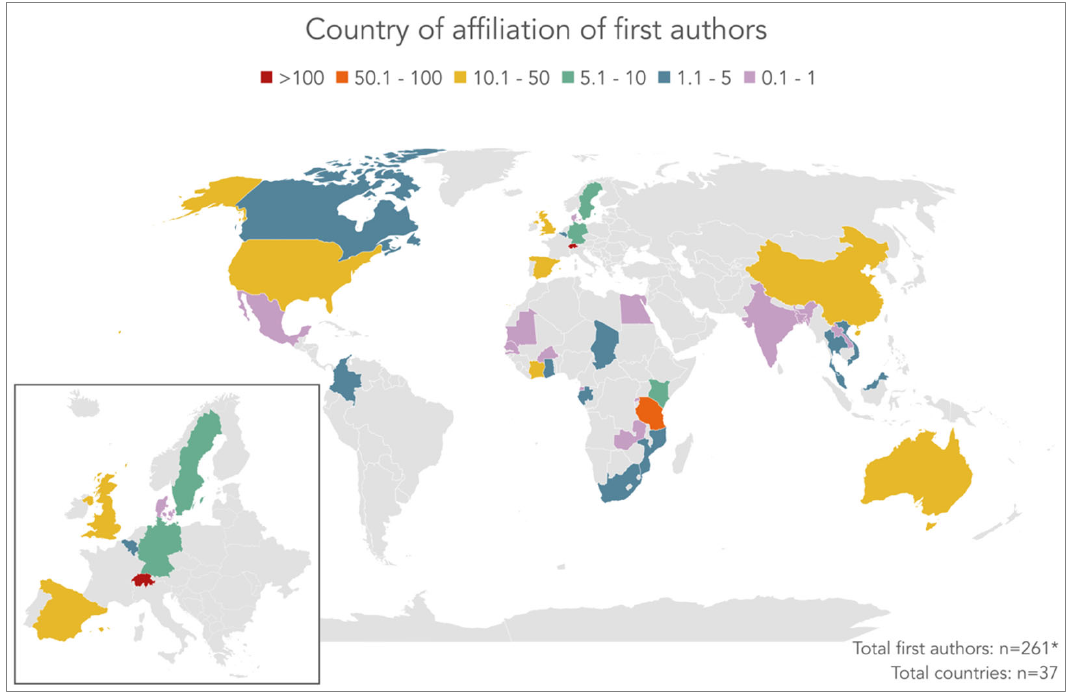
Figure 3. Country affiliation of first authors in peer-reviewed articles co-authored by Marcel Tanner between 1978 and 2021. * For one first author, country affiliation could not be determined (source: Web of Science Core Collection, search performed on 3 August 2022, complemented with internet searches in case of missing